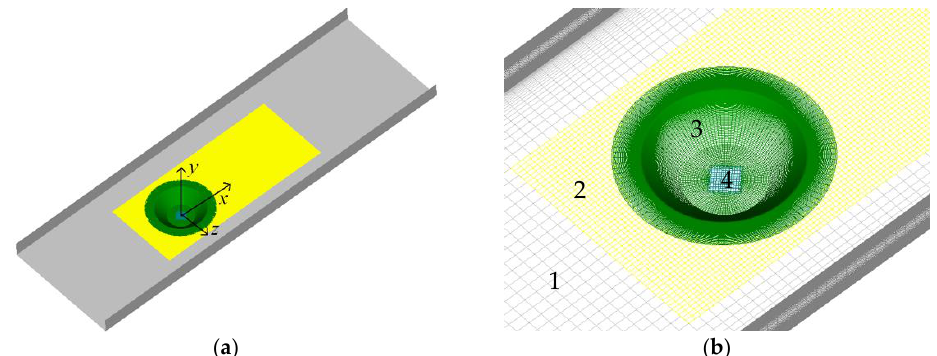
Figure 1. Area of the plane-parallel channel with a conical dimple on the heated wall ( a ) with the Cartesian x,y,z coordinate system and multiblock grids in the vicinity of the dimple ( b ). 1—channel grid (CG); 2—refined Cartesian grid (wake grid—WG) covering the dimple, 3—O-shaped grid Ring inside the dimple, and 4—grid Rec—axial “patch”. The upper wall is removed. The heat and hydrodynamic tasks (the natural convection effects were not taken into account) were solved separately. The flow at the channel inlet was isothermal and had a temperature 𝑇 𝑟𝑒𝑓 = 293𝐾 . The lower streamlined channel wall with a dimple was heated.